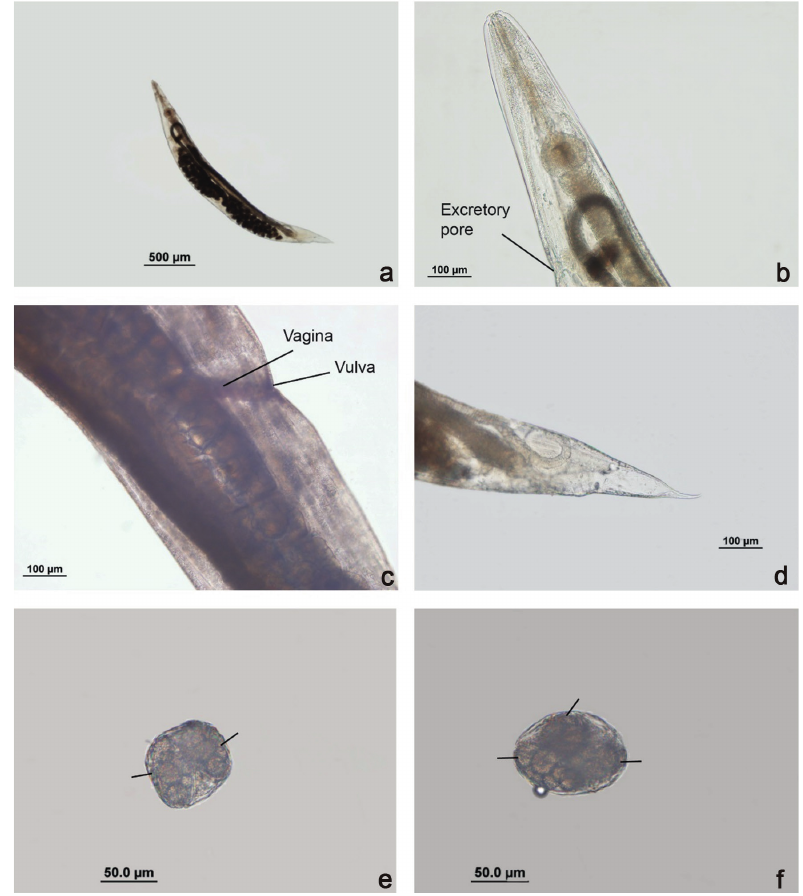
Figure 1 - Binema korsakowi . a . Female, entire. b . Cephalic region. c . Vulval region (lines showing the vulva and the vagina). d . Tail. e . Capsule containing 2 eggs (lines). f . Capsule containing 3 eggs